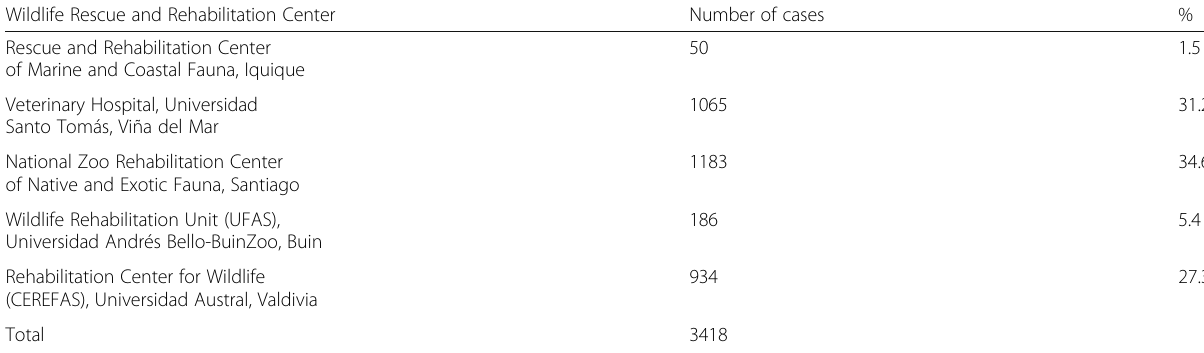
Table 1 Centers included in this study, number of cases analyzed between 2011 and 2015, and proportion of data contribution to total